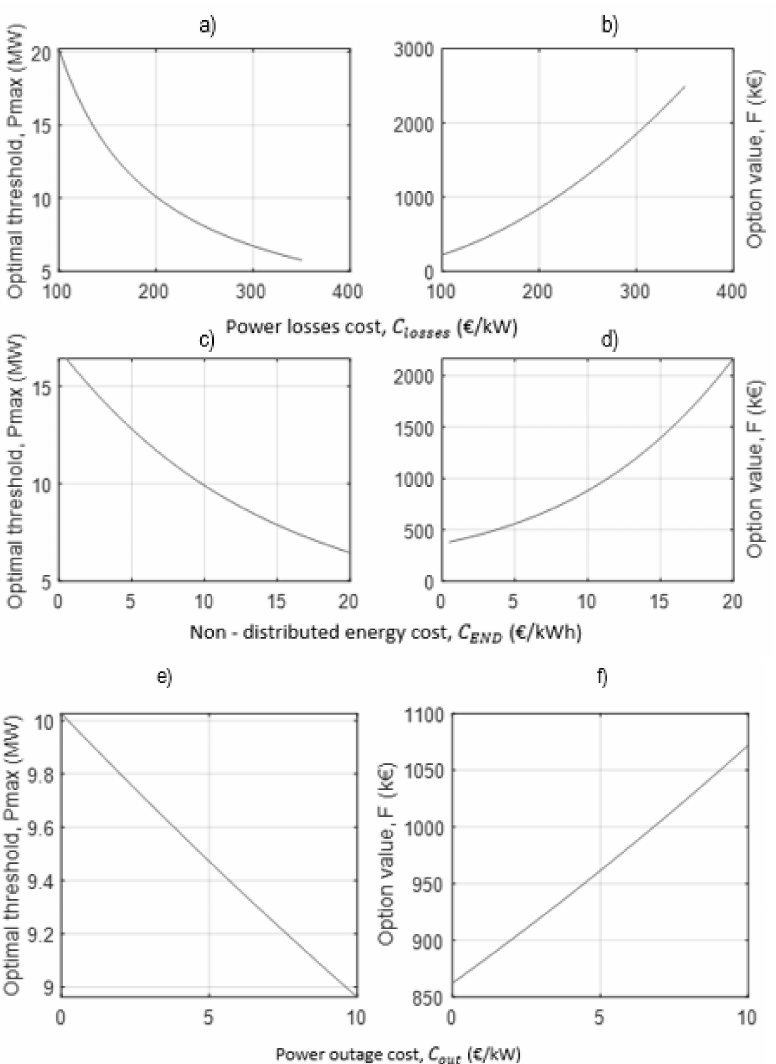
Figure 16. Sensitivity analysis of power losses cost ( top ), non-distributed energy cost ( mid ), and power outage cost ( bottom ) for optimal threshold ( a , c , e ) and option value ( b , d , f